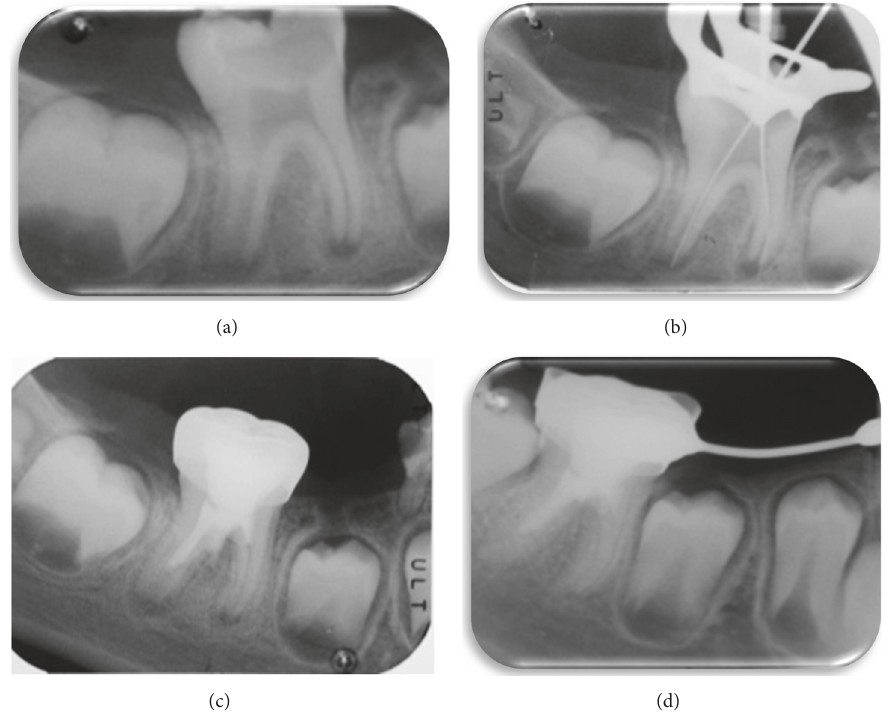
Figure 5: (a) First visit showing occlusal caries on tooth 46 extending to the pulp chamber, with open apices. (b) Determination of working length. (c) End of revascularization therapy, having placed MTA and metal crown . (d) Follow-up radiograph. Apical closure of both roots is shown and radiotranslucencies have disappeared. A complication associated with revascularization is obliteration of the root canals that is shown